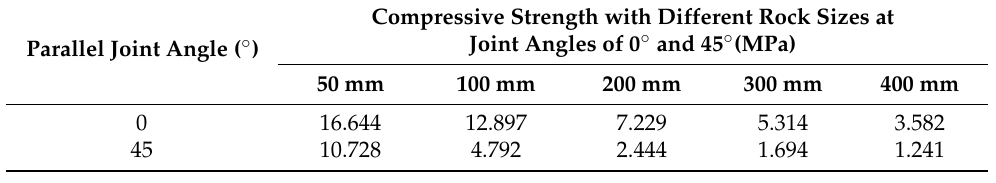
Table 14. Compressive strength with different rock sizes at joint angles of 0 ◦ and 45 ◦ . Parallel Joint Angle ( ◦ )